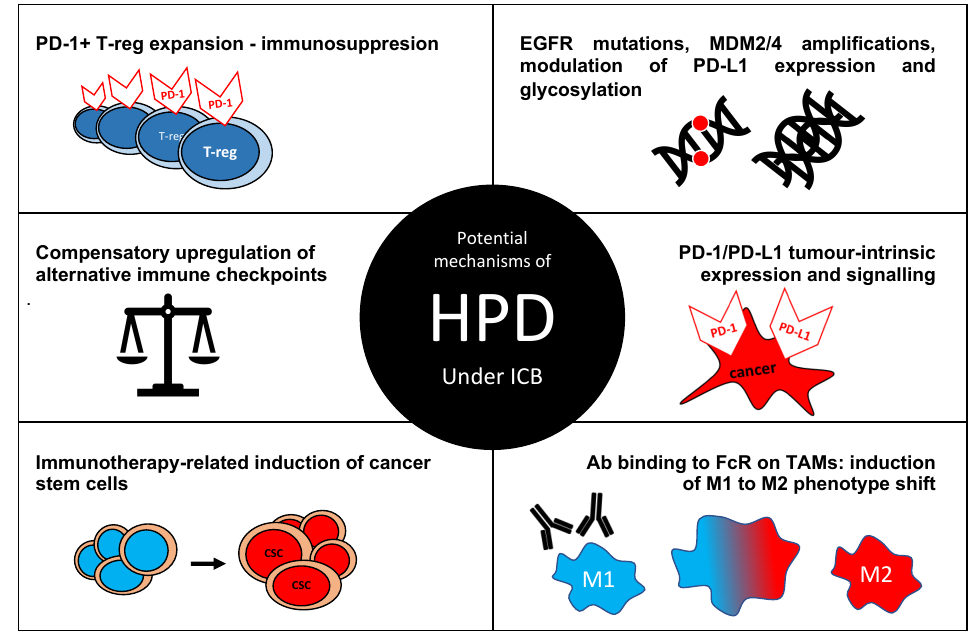
Figure 1. Postulated mechanisms of hyperprogressive disease (HPD) in cancer under immune checkpoint blockade (ICB). Ab—antibody, FcR—Fc receptor, TAM—tumour-associated macrophage; M1—apro-inflammatorymacrophagephenotype, M2—anti-inflammatoryphenotypeknowntosupport tumour growth and